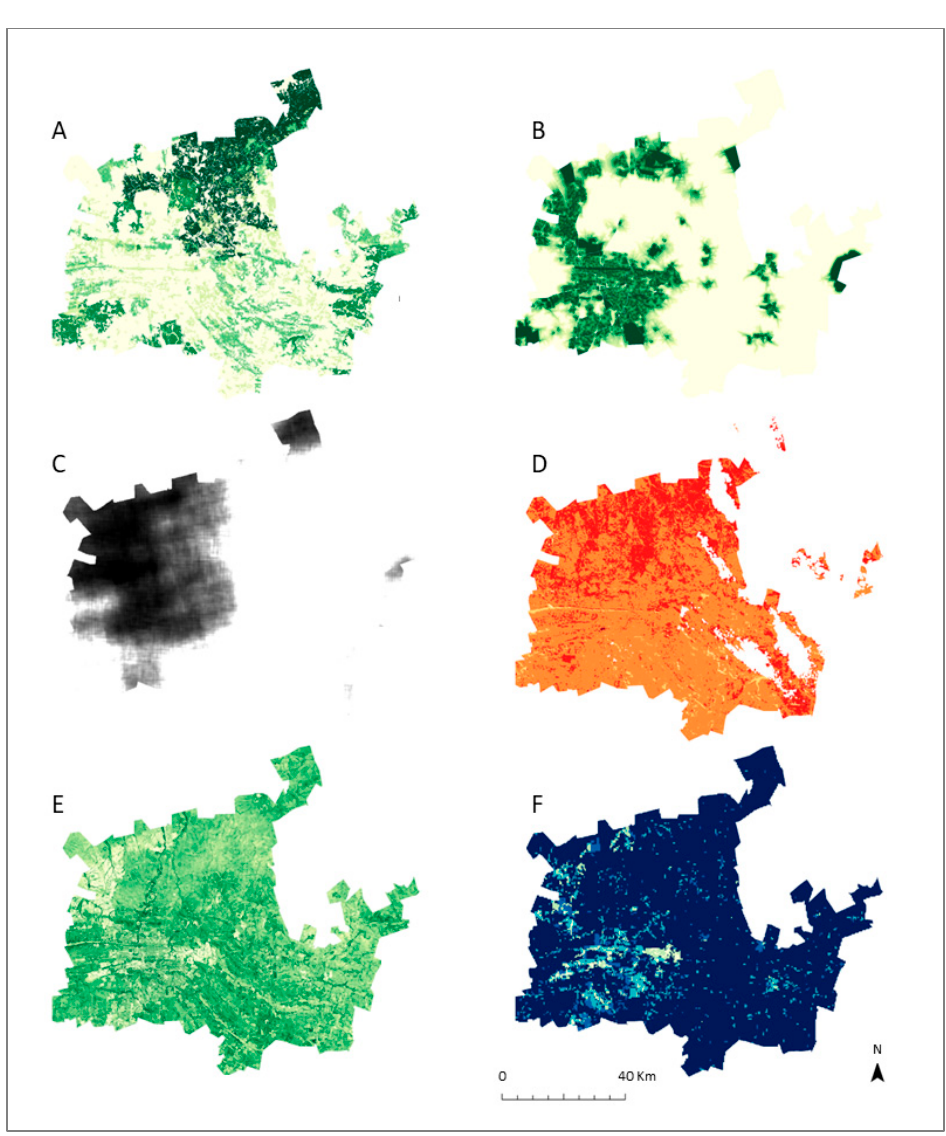
Figure 3. Maps scaled 0–9 representing the multifunctional benefits of green infrastructure. ( A ) Habitat connectivity, ( B ) accessibility measured as the walking distance to public parks, ( C ) mean cumulative air-pollution, ( D ) land surface temperature, ( E ) normalized difference vegetation index, and ( F ) current flooding risk. These maps were assembled into a decision support tool for multi-criteria decision analysis.